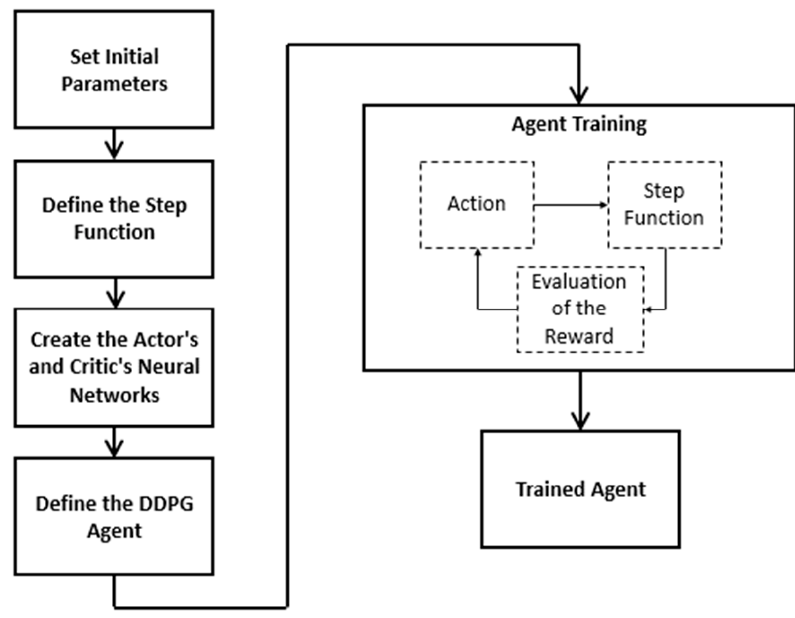
Figure 1. Flowchart of the DDPG method of agent generation.